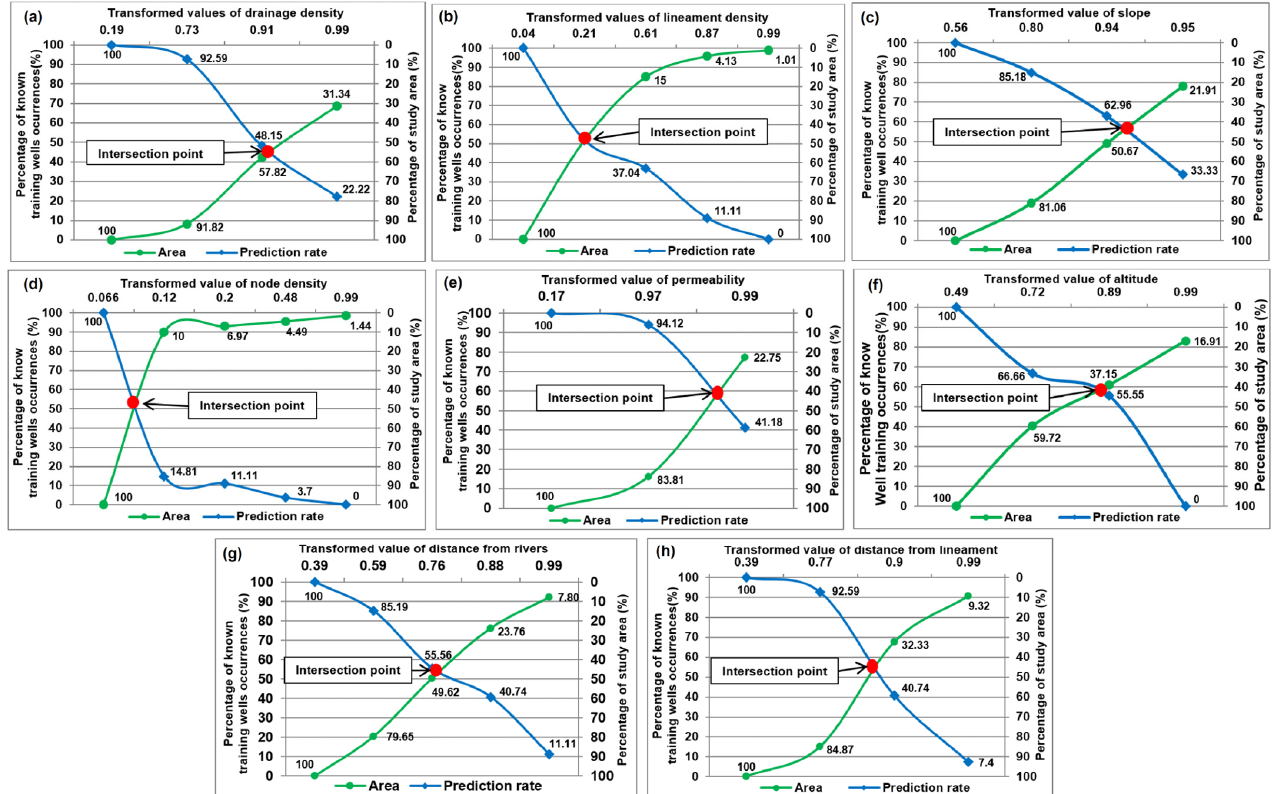
Figure 7. Prediction-area (P-A) plot for the classified map: ( a ) drainage density map; ( b ) lineament density map; ( c ) slope map; ( d ) node density map; ( e ) permeability map; ( f ) altitude map; ( g ) distance from rivers map; ( h ) distance from lineament map.